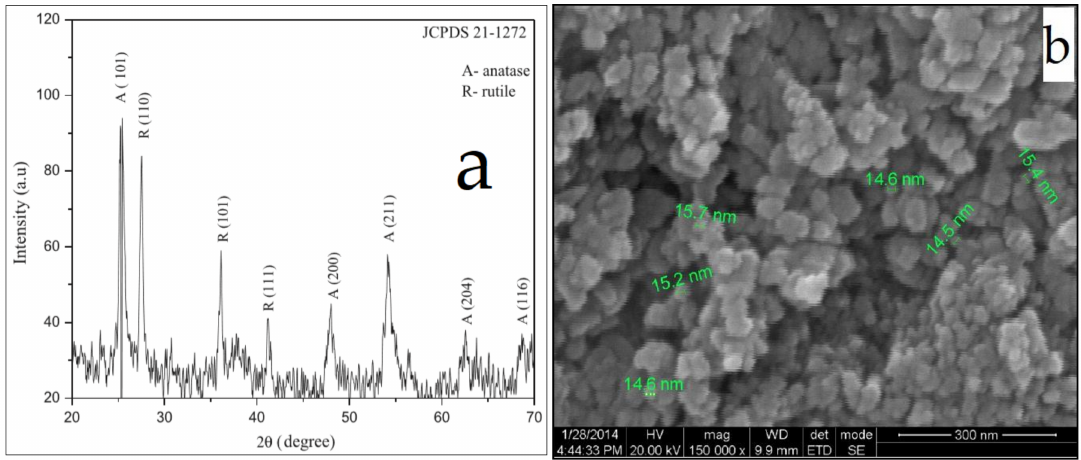
Figure 9. ( a ) XRD pattern of TiO 2 ; ( b ) HR-SEM morphology of TiO 2